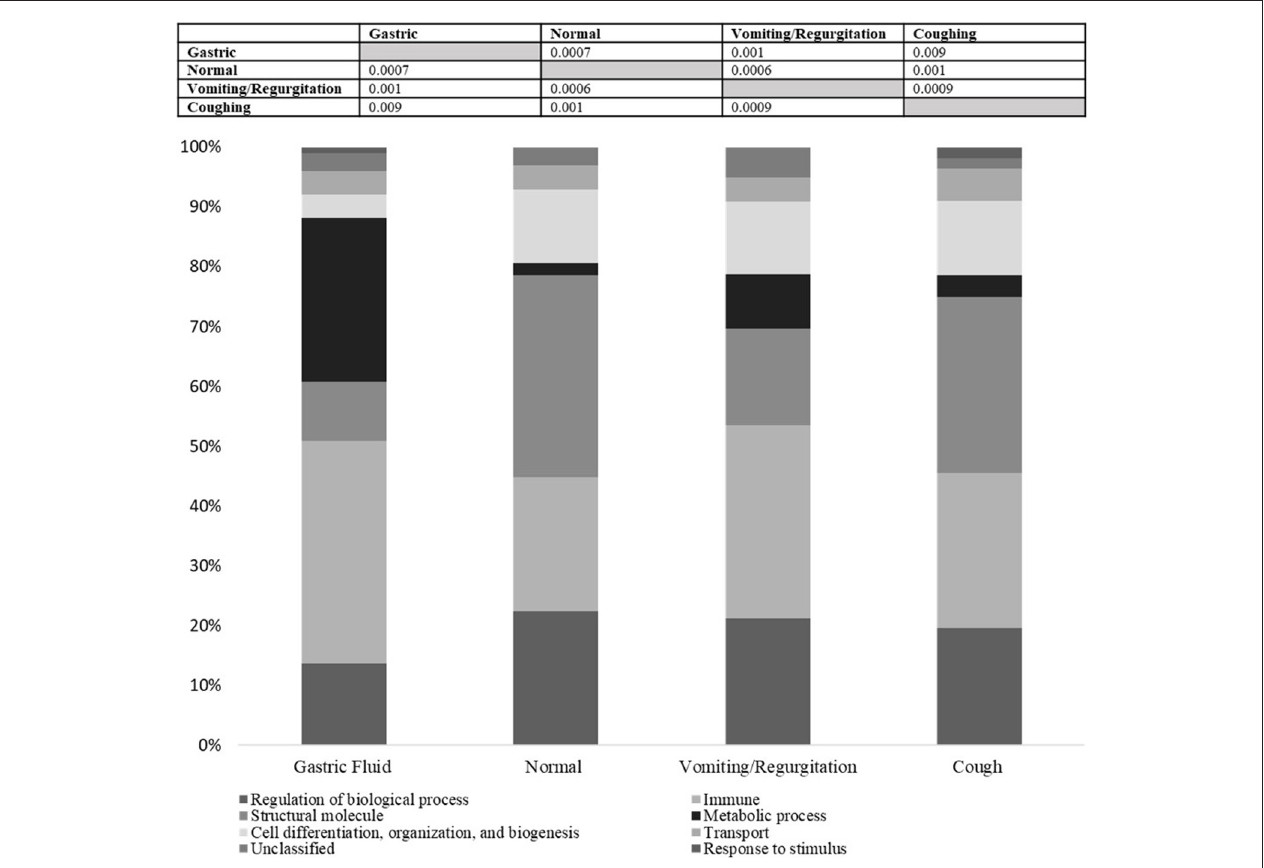
FIGURE 2 | All groups were statistically dissimilar by ANOSIM based on the biological function of identified proteins ( p ≤ 0.001). This suggests that the functional proteome differs by site (gastric fluid vs. oropharyngeal, OP) as well as between health and disease. The biological function profile for each group is displayed in the stacked bar chart above. Metabolic and immune proteins were over-represented in gastric fluid compared to normal dog OP swabs ( p < 0.05). Metabolic proteins were over-represented in vomiting/regurgitating dog OP swabs compared to healthy dogs ( p < 0.05) as were proteins with immunologic function ( p < 0.05). Coughing dog OP swabs had increased the number of proteins involved in cellular differentiation and stimulus response compared to normal and regurgitating/vomiting dogs ( p <